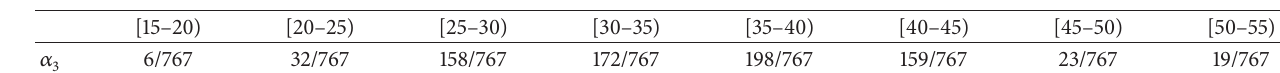
Table 4: AgeBinned univariate 𝛼 3 .